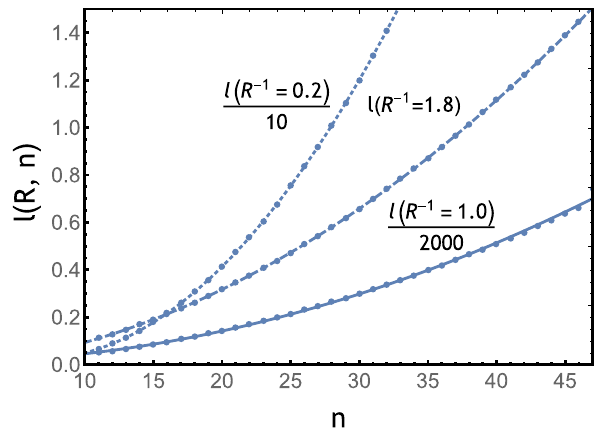
Fig. 1 Fitting the l ( R = { 0 . 2 − 1 , 1 . 0 − 1 , 1 . 8 − 1 } ( gB ) − 1 / 2 , n ) with l = a ( R ) + b ( R ) n + c ( R ) n 2